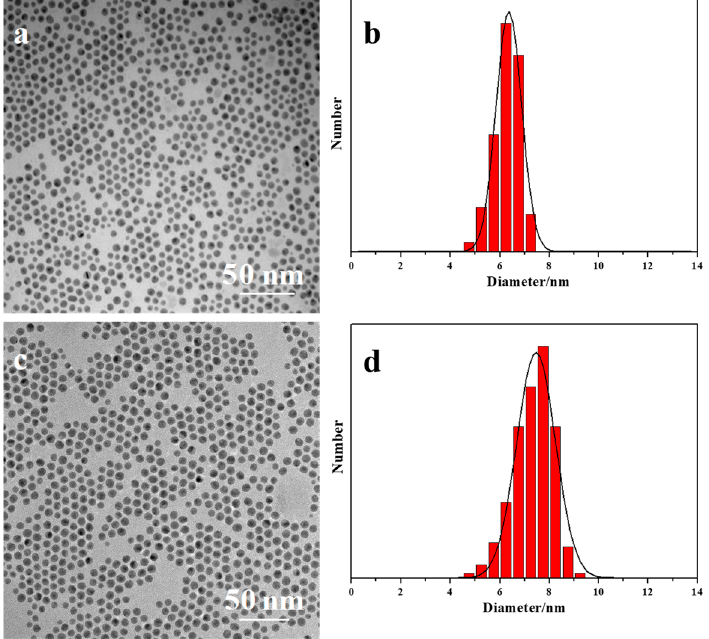
Figure 3. TEM images and the corresponding particle size distributions of Au NPs obtained using toluene as solvent at different temperate: ( a , b ) 75 ◦ C and ( c , d ) 90 ◦